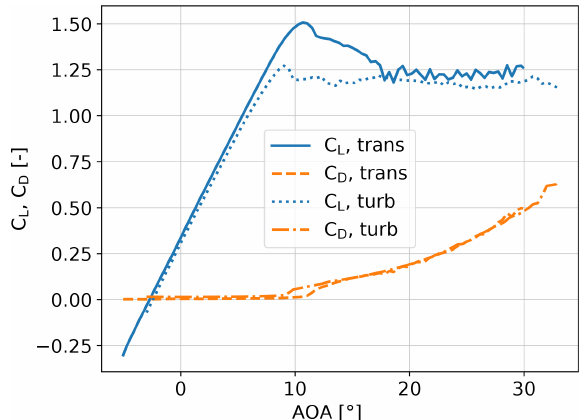
Figure 2. C l and C d versus angle of attack for the FFA-W3-211 airfoil in free transition and fully turbulent conditions (KTH wind tunnel data; Bertagnolio et al., 2001).